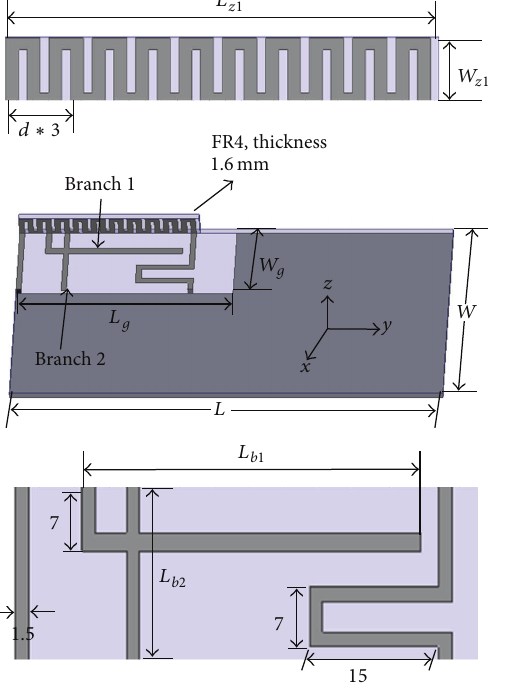
Figure 1: The geometry of the proposed antenna.